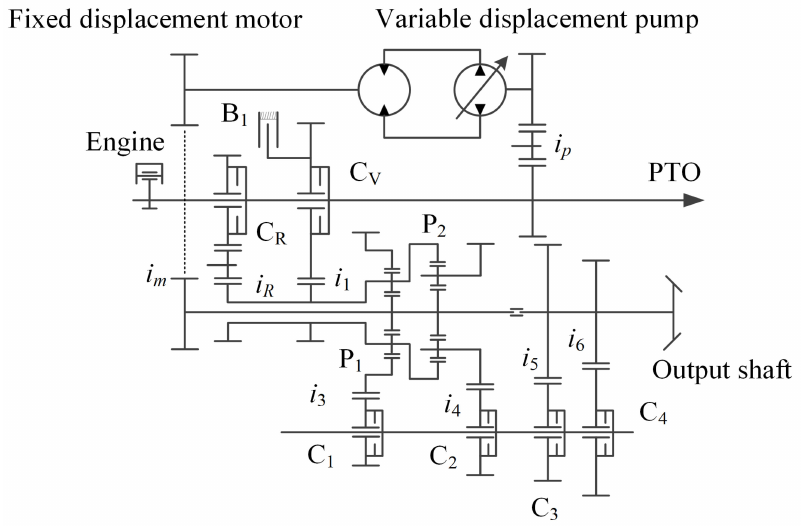
Figure 1. Schematics of five-stage HMCVT proposed in this paper.